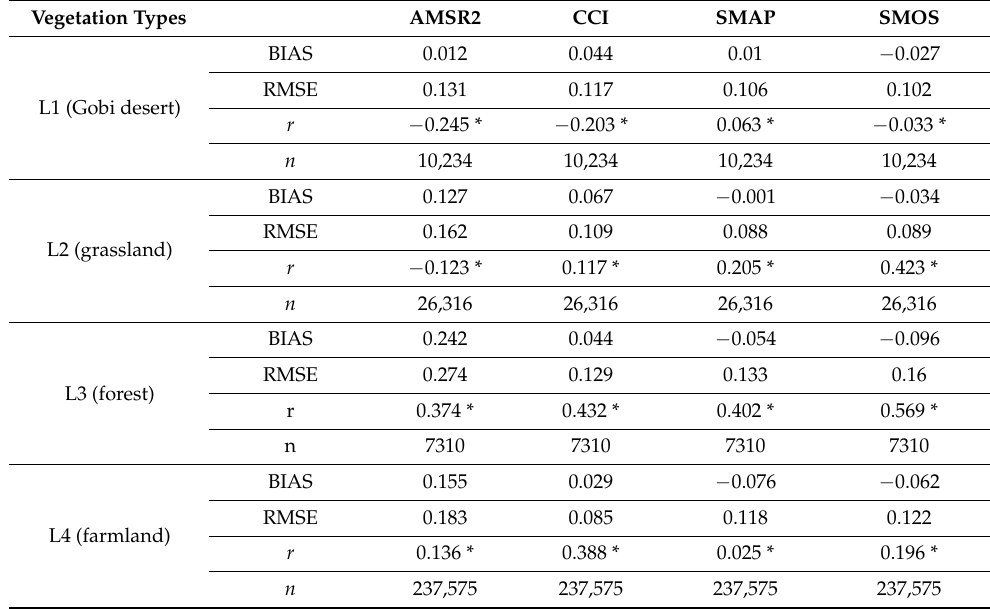
Table 4. Estimated errors and correlation coefficients of soil moisture products in different vegetation